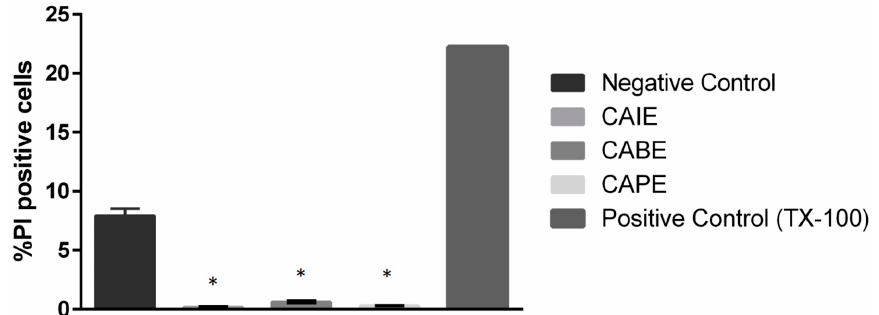
Figure 1. Bacteriostatic e ff ect of the novel inhibitory compounds on Paenibacillus larvae. Cells were incubated in brain-heart infusion medium supplemented with 1 mg / L thiamine (BHIT) at 37 ◦ C for 18 h with 125 µ g / mL of CAIE, CABE, CAPE, or TX-100 before staining with propidium iodide (PI). Fluorescence was quantified through flow cytometry. Data presented are mean percent PI positive cells ± standard deviation (SD) ( n = 3). Asterisks represent a significant di ff erence between control cells and cells exposed to TX-100 (positive control ( p <